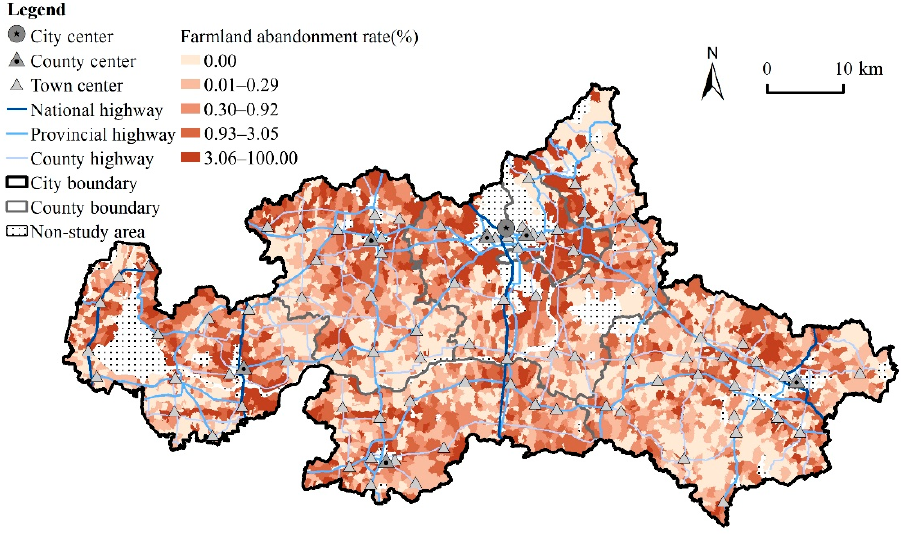
Figure 2. The spatial distribution of farmland abandonment rate.